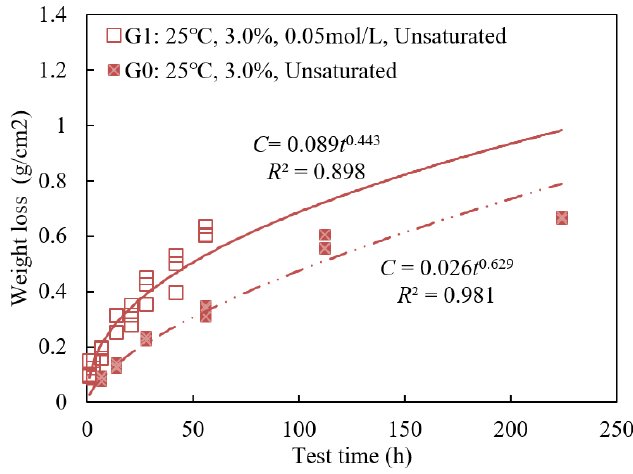
the corrosion process of B10 alloy.